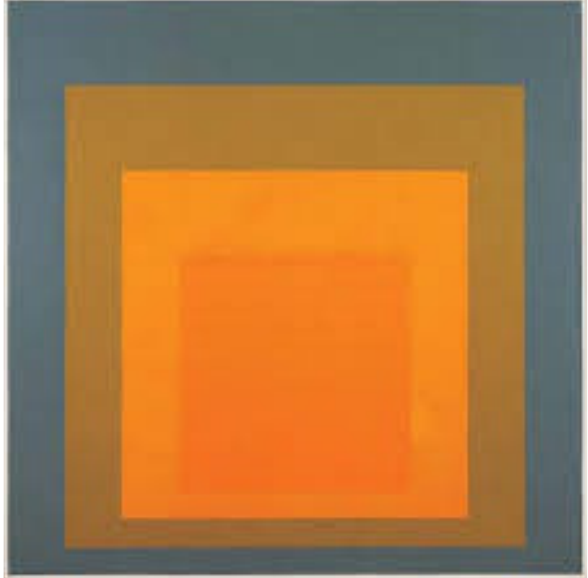
Figure 12 | Josef Albers (1888-1976). Figure 11 | Josef Albers, Homage to the square: Festive, 1967